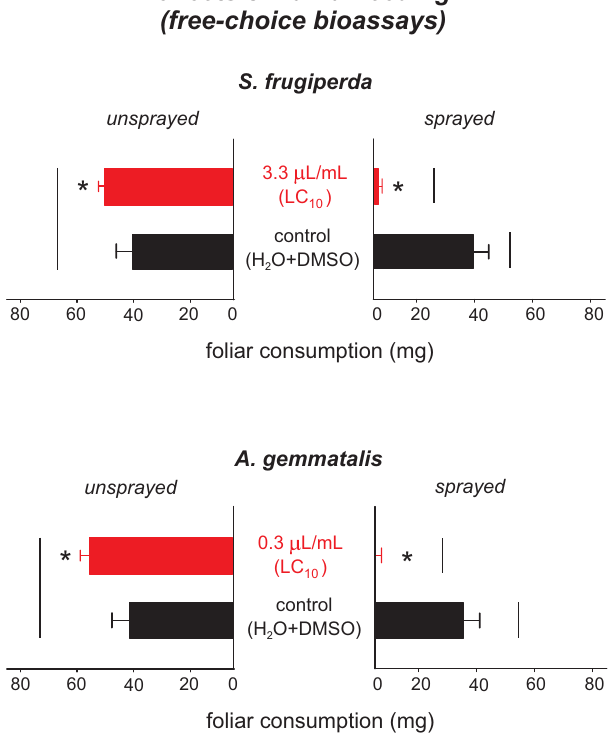
Figure 5. Foliar consumption (mg) of the 3 rd instar larvae of Spodoptera frugiperda and Anticarsia gemmatalis feeding on sprayed with sublethal dose (LC 10 of Siparuna guianensis essential oil) and unsprayed leaves of maize or soybean. Asterisks indicate significant differences ( P < 0.05) between sprayed and unsprayed leaves of the same treatment. Horizontal bars indicate significant differences ( P < 0.05) between the leaves sprayed either with the essential oil of Siparuna guianensis or unsprayed